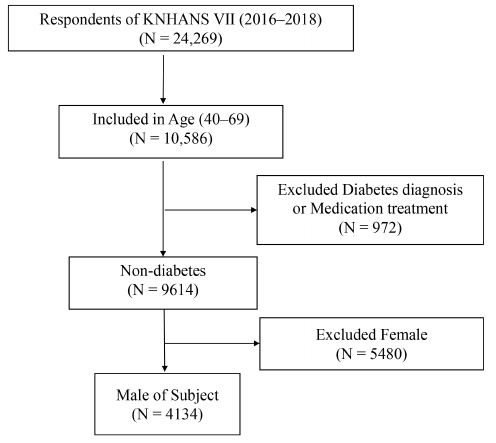
Fig. 1. Flow chart of the study